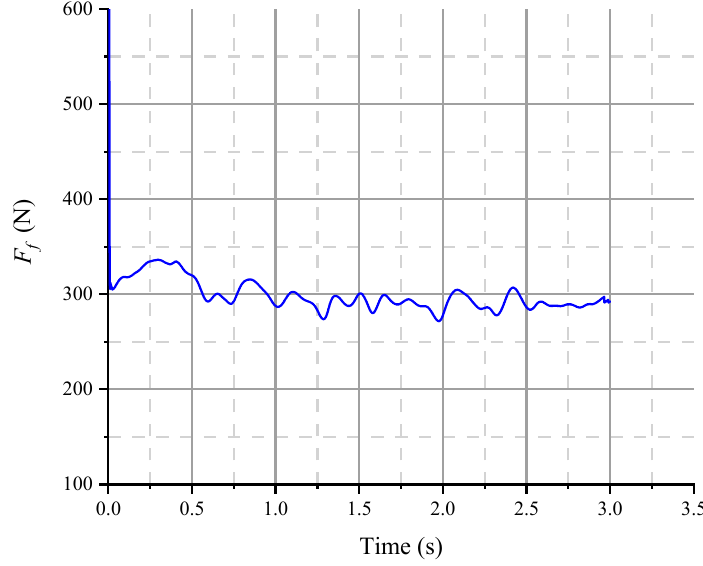
Figure 12. Resistance convergence results of constrained straight-line cruising simulation.